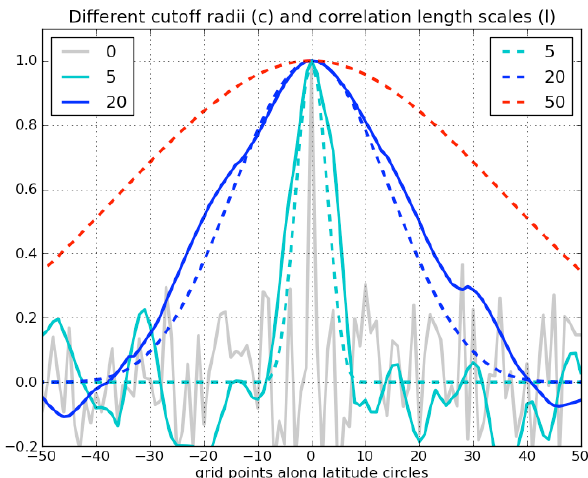
Fig. 3. Illustration of cutoff radius and correlation functions with different length scales. The length scales are specified in units of grid points. The dashed lines show the Gaspari–Cohn localization functions with different cutoff length scales (c) . The solid lines are correlation functions. For example, the solid blue line shows the correlation between α at the grid point marked 0 on the x-axis and the neighboring grid points for l = 20.